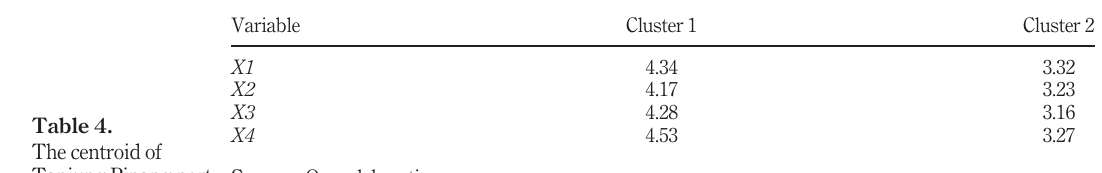
Table 4. The centroid of Tanjung Pinang port